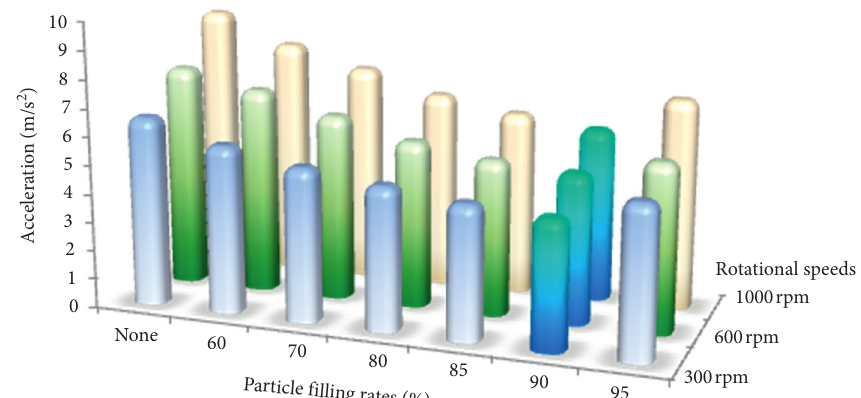
Figure 11: Acceleration